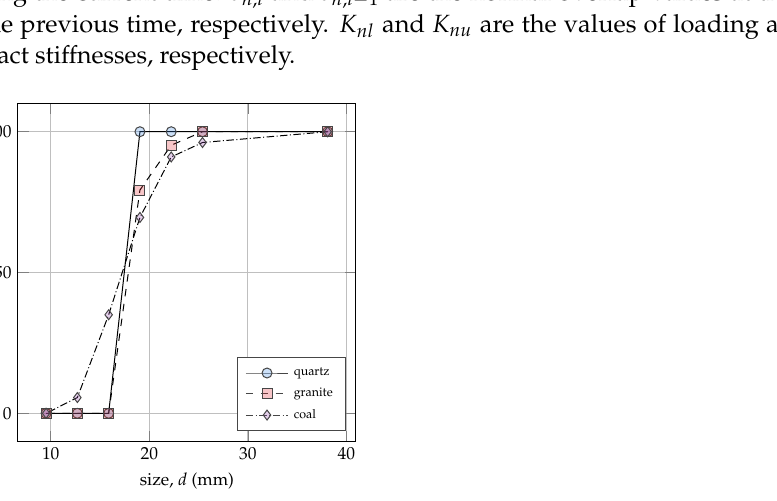
Figure 1. Particle size distribution of quartz, granite, and coal samples used in the